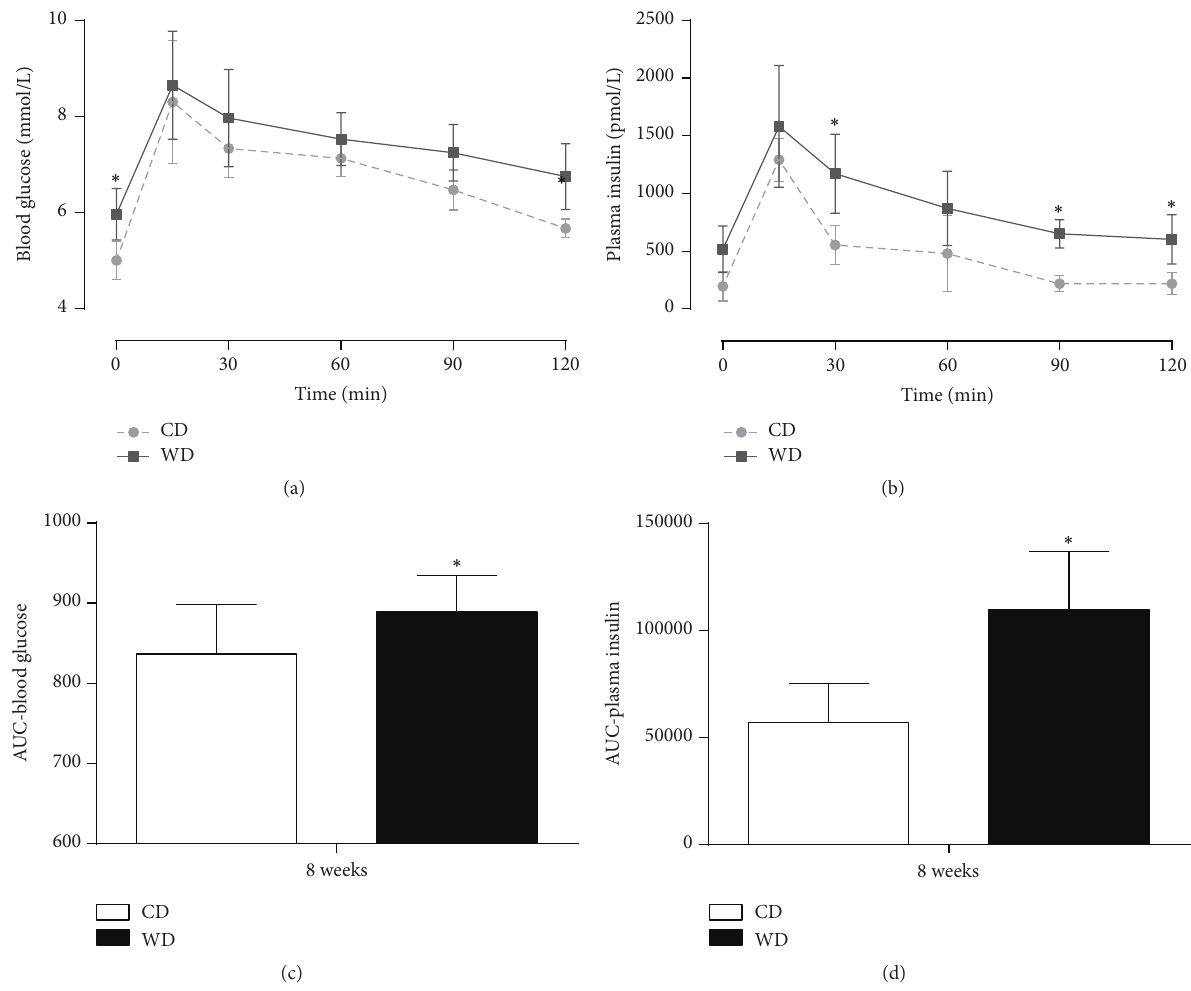
Figure 1: Oral glucose tolerance after 8 weeks of diet feeding. Blood glucose (a), plasma insulin (b), and area under the curve (AUC; (c) and (d)) during an oral glucose tolerance test in rats after 8 weeks of control diet (CD) and western diet (WD) feeding. Data are mean ± SD, 𝑛 = 6 , 𝑡 -test, one- and two-way ANOVA with repeated measures, and Bonferroni post hoc analyses, ∗ 𝑝 < 0.05 versus CD.